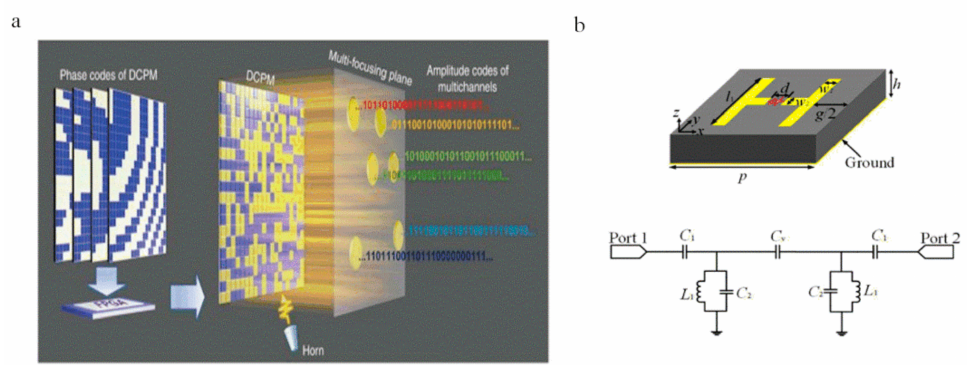
Figure 3. ( a ) Diagram of a multichannel transmission system in the near field region. Adapted with permission from ref. [92]. Copyright 2019 Springer Nature. ( b ) Unit cell loaded with a varactor diode. Reprinted with permission from ref. [93]. Copyright 2018 Optical Society of